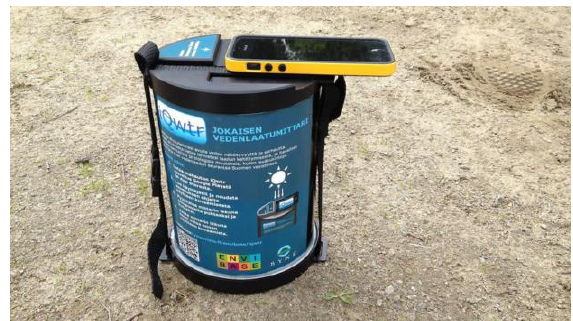
Figure 7: The iQwtr device (Bonnor, 2015)